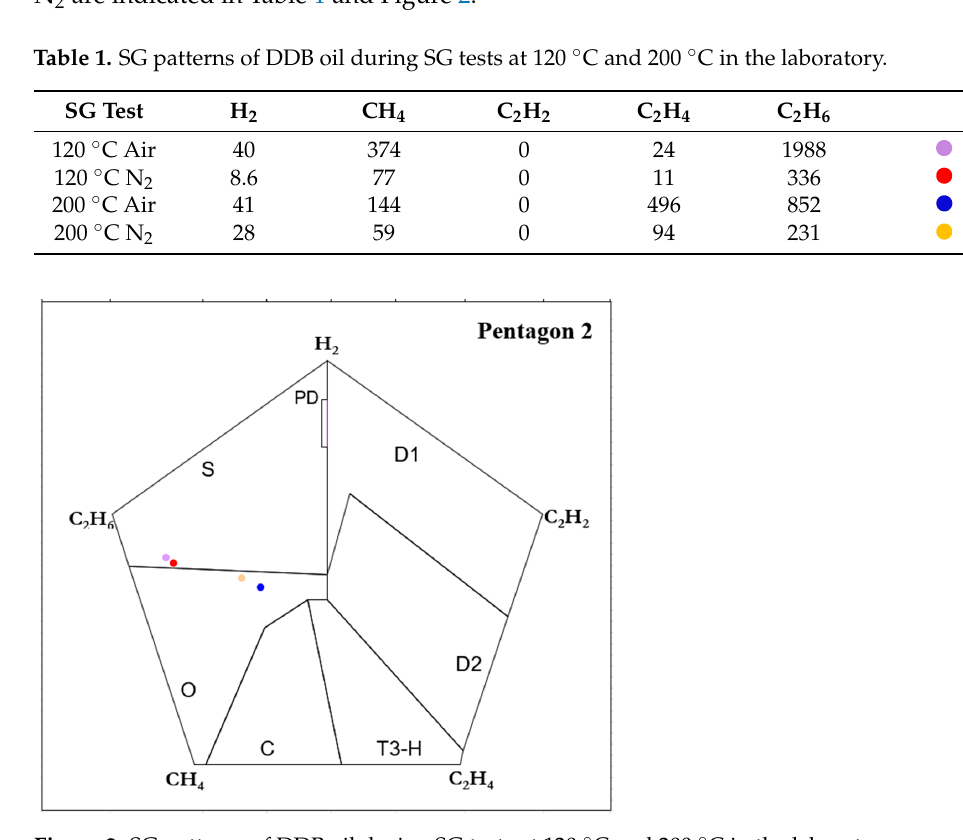
Figure 2. SG patterns of DDB oil during SG tests at 120 °C and 200 °C in the laboratory.